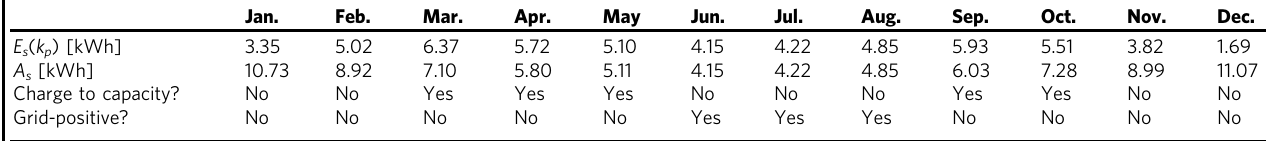
Table 1 Monthly simulation results for Munich,